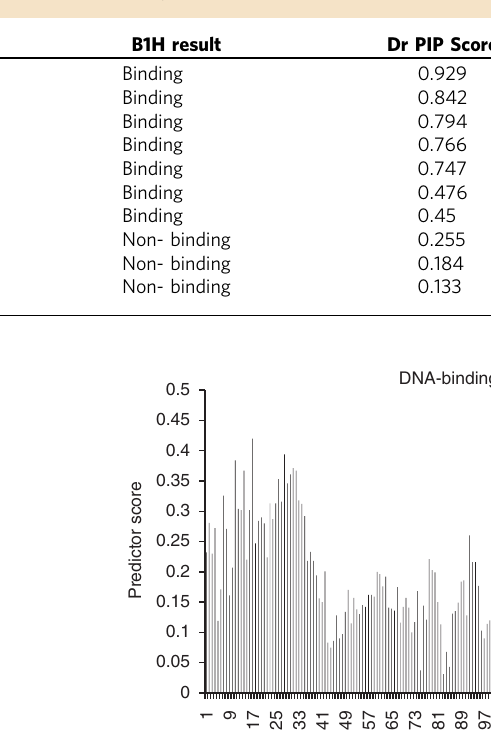
Table 1 | Experimental B1H 21 results for DNA binding and Dr PIP prediction of the experimental data set.